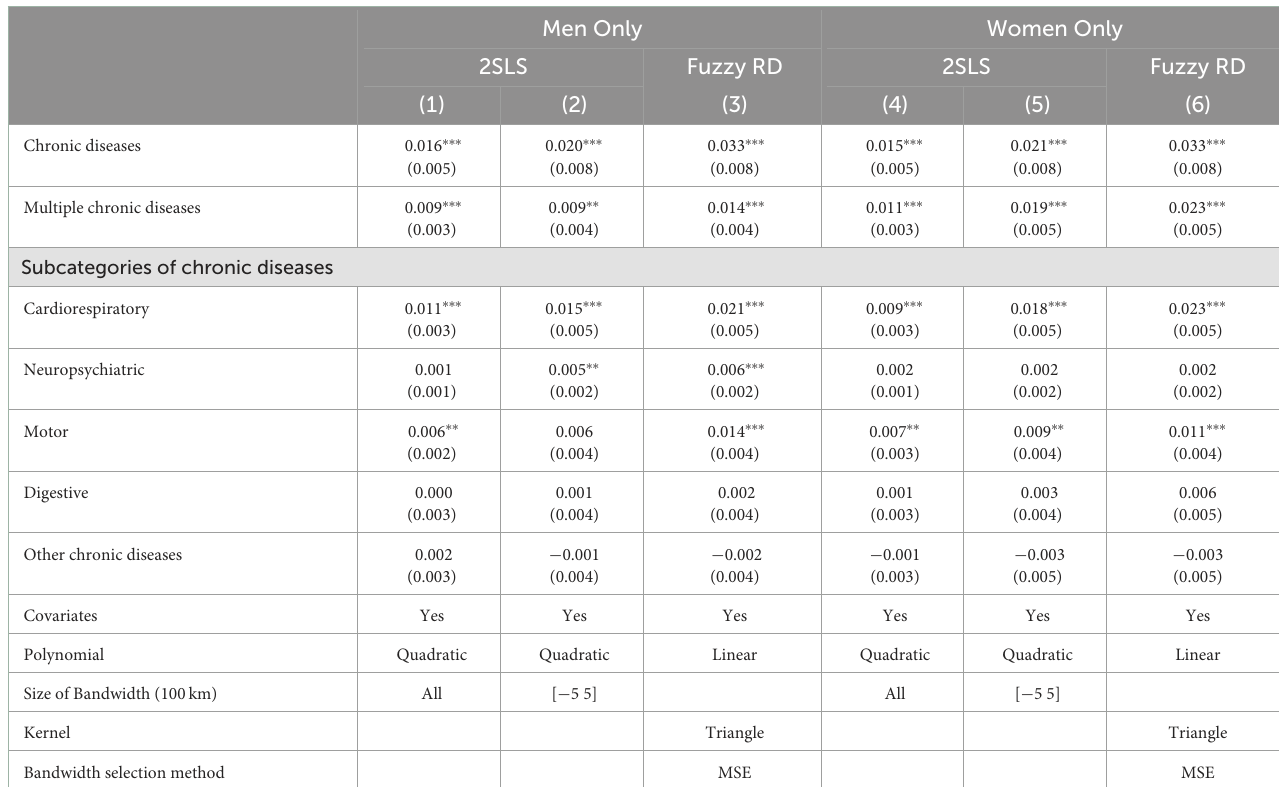
TABLE 8 Heterogeneous effect of the Huai river policy on chronic diseases by gender.